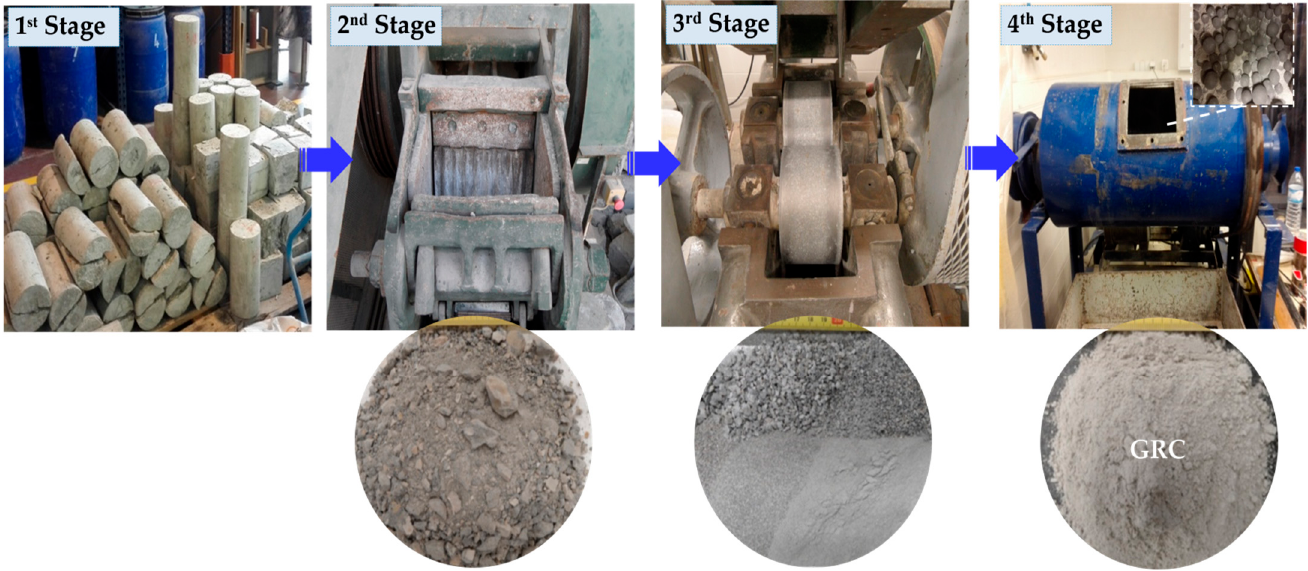
Figure 1. Four stages of GRC preparation.